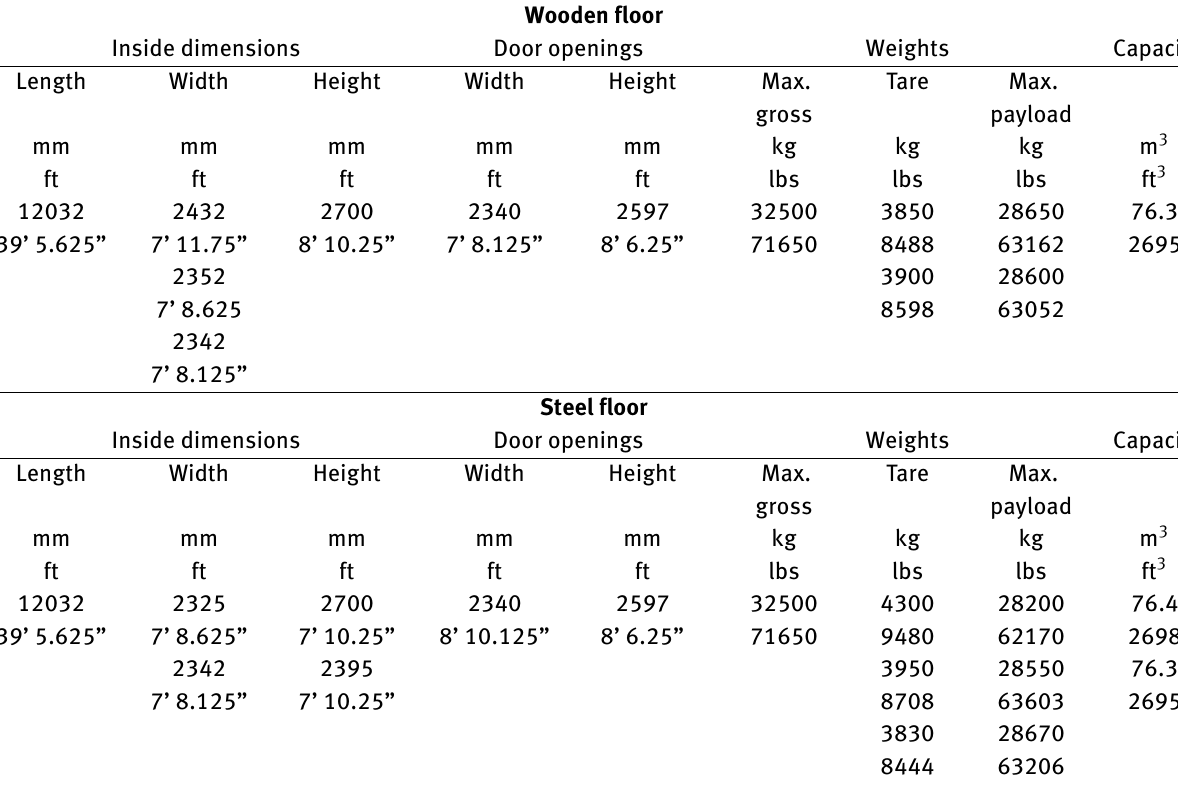
Table 2: High cube general purpose container 40’